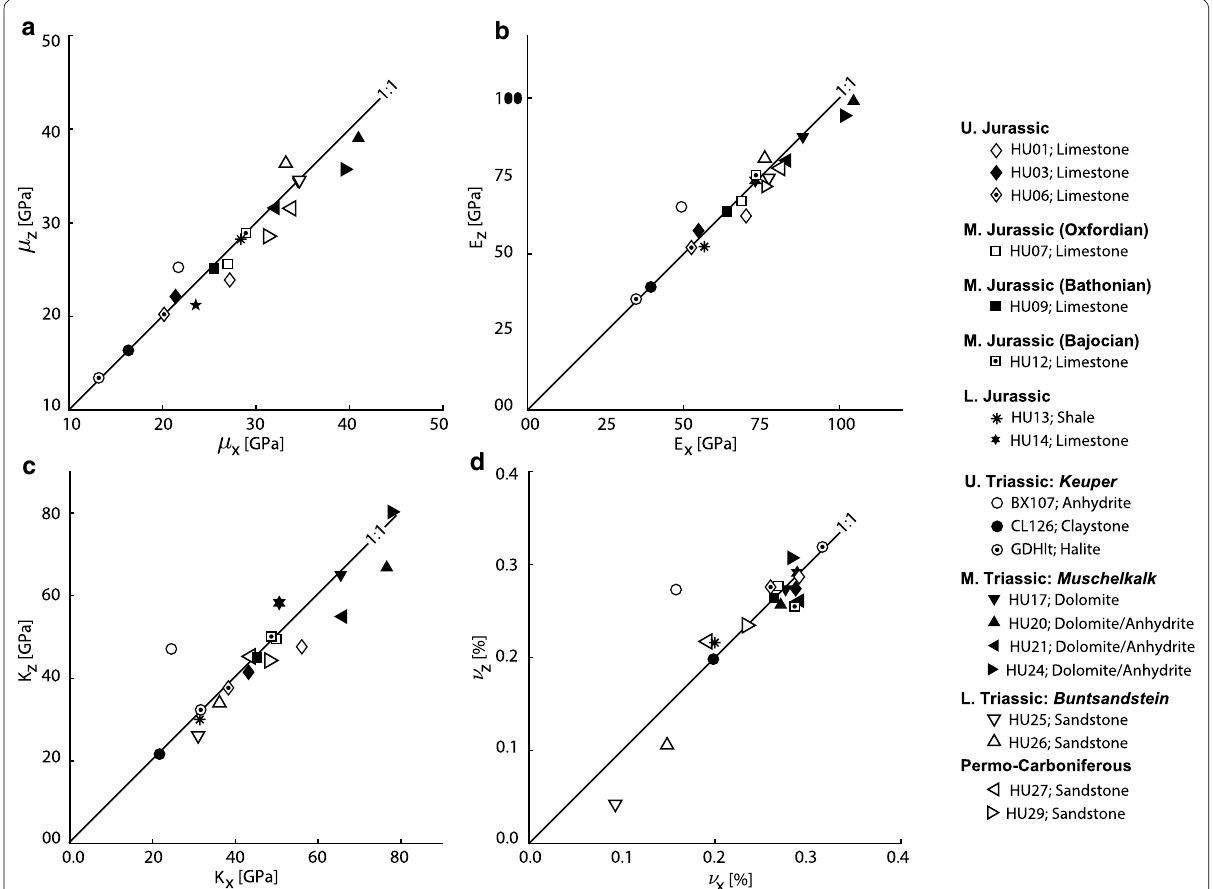
Fig. 11 Cross-plots for the studied plugs of a horizontal and vertical shear Modulus ( µ ), b horizontal and vertical Young modulus (E), c horizontal and vertical Bulk Modulus (K), and d horizontal and vertical Poisson’s ratio ( ν